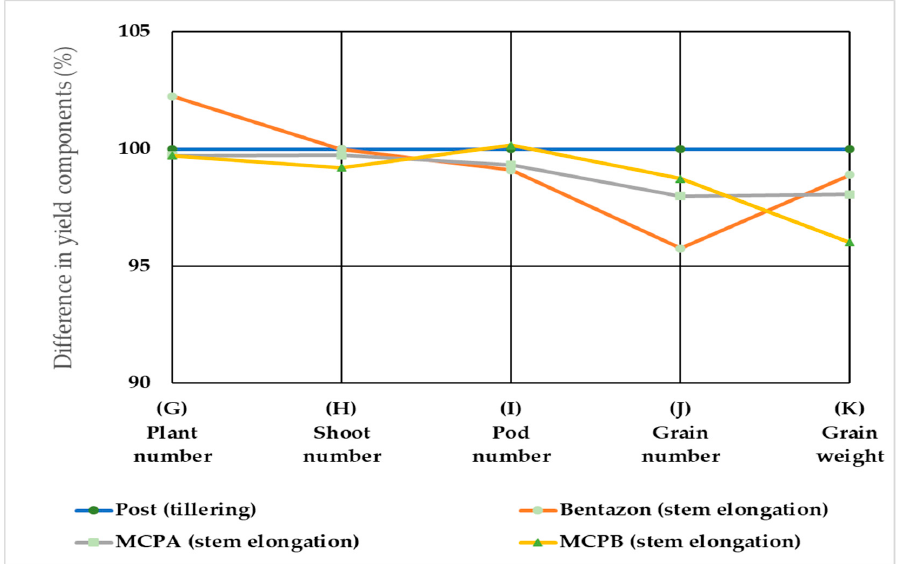
Figure 11. The effect of the timing of post-emergence treatments without pre-emergence treatment on the development of associated winter pea ( Pisum sativum L.), over an average of 2 years. The development lines of the associated winter wheat in the case of late post-emer- gence treatment can be seen in Figure 5. The 100% levels are represented by the yield components where late post-emergence treatments were applied (treatments 14, 15, 16) without pre-emergence treatments. Comparing these values to the yield components of pre-emergence and late post-emergence treatments (treatments 8, 9, 10), pendimethalin resulted in only a 3% difference in the number of plants, and a 1–2% difference in the number of shoots, which are both statistically insignificant. However, the use of pendime- thalin increased the number of ears (4–8%), the number of spikelets (2–4%), the number of grains (6–7%), and the total grain weight/m 2 (6–5%) compared to treatments without pre-emergence herbicides (Figure 5).